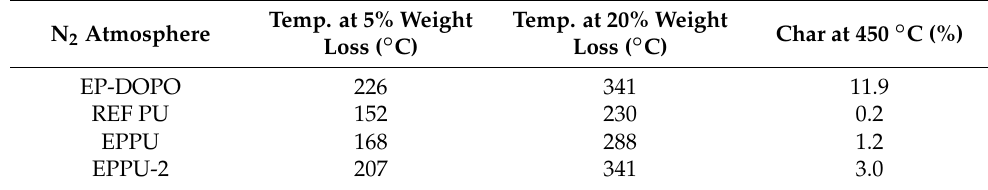
Table 2. Thermal degradation temperatures of polyurethanes obtained with thermogravimetric analysis (TGA) (N 2 ).